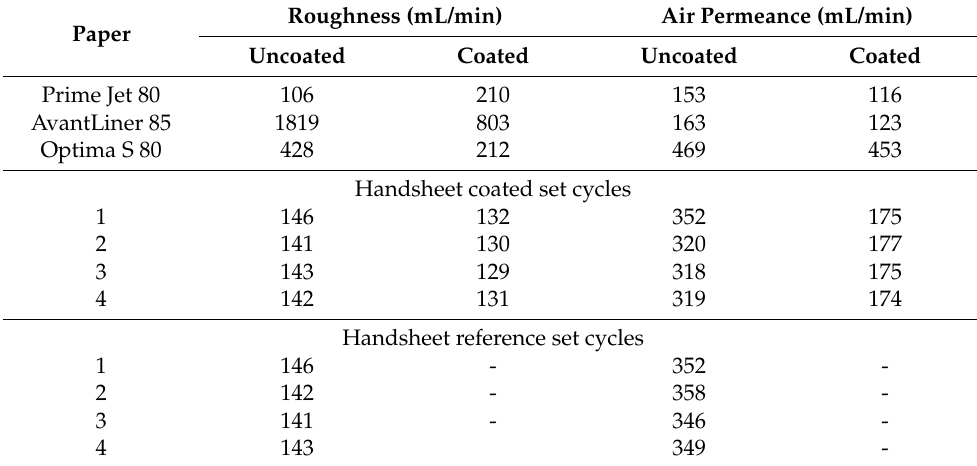
Table 6. Surface roughness and air permeance of paper samples and handsheets prepared in recy- cling cycles.